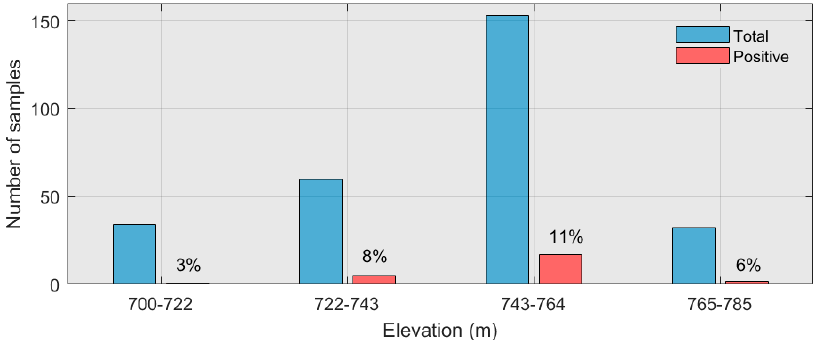
Figure 4. Relationship between ground elevation of residences in Aida Camp and rooftop-tank water testing results. Percentage (%) of total samples in each elevation group that tested positive are shown next to the bars.